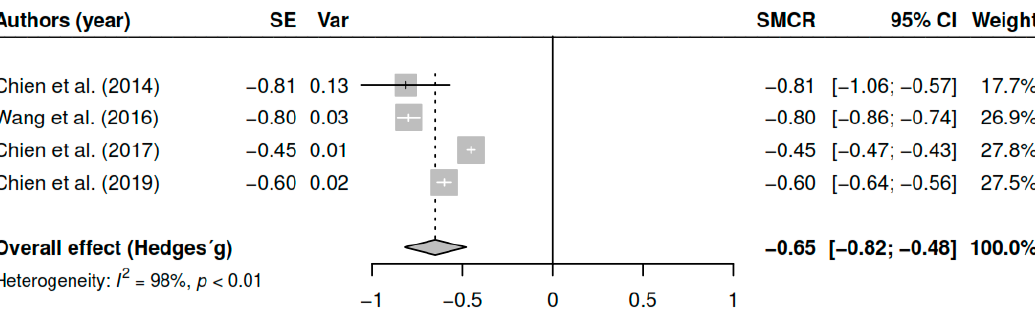
Figure 8. Forest plot for the model of random-effects and the values of Hedges’ g statistics in the awareness of illness variable (pretest–posttest).